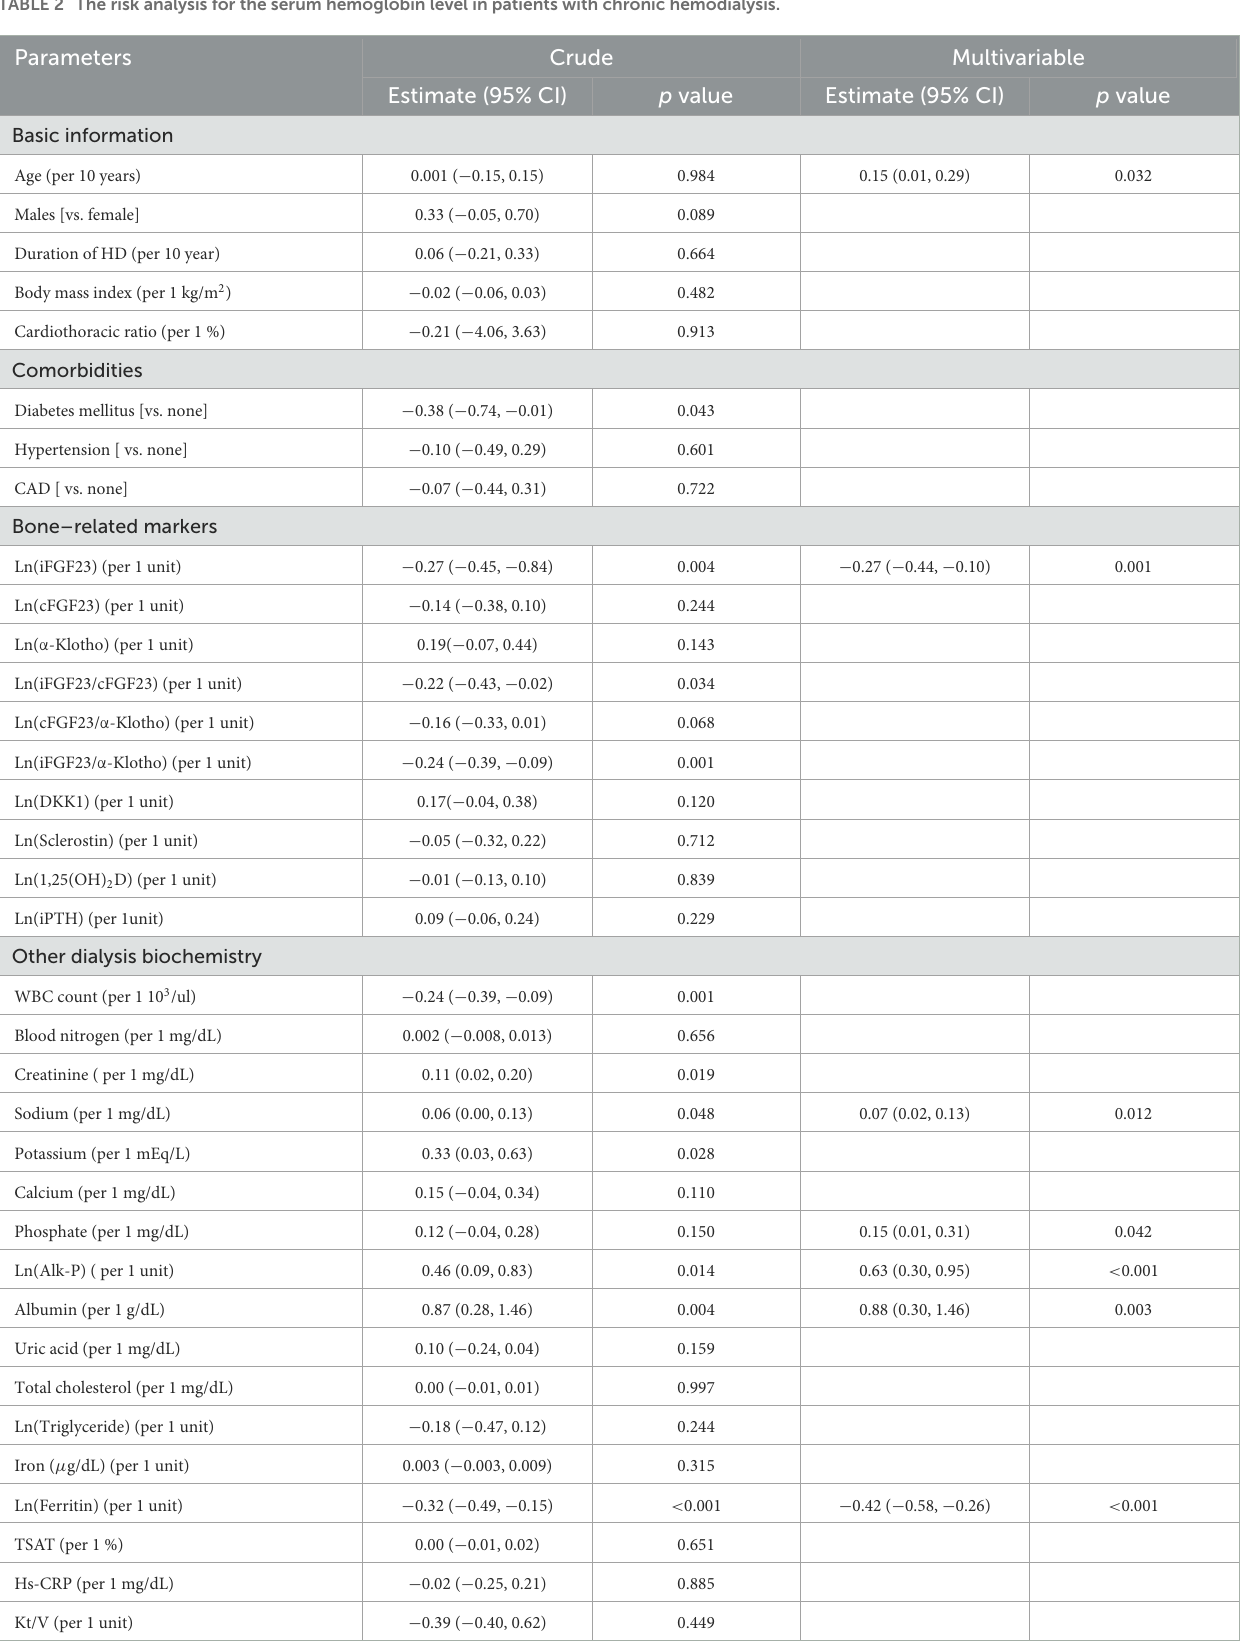
TABLE 2 The risk analysis for the serum hemoglobin level in patients with chronic hemodialysis. Parameters Crude Multivariable Estimate (95% CI) p value Estimate (95%